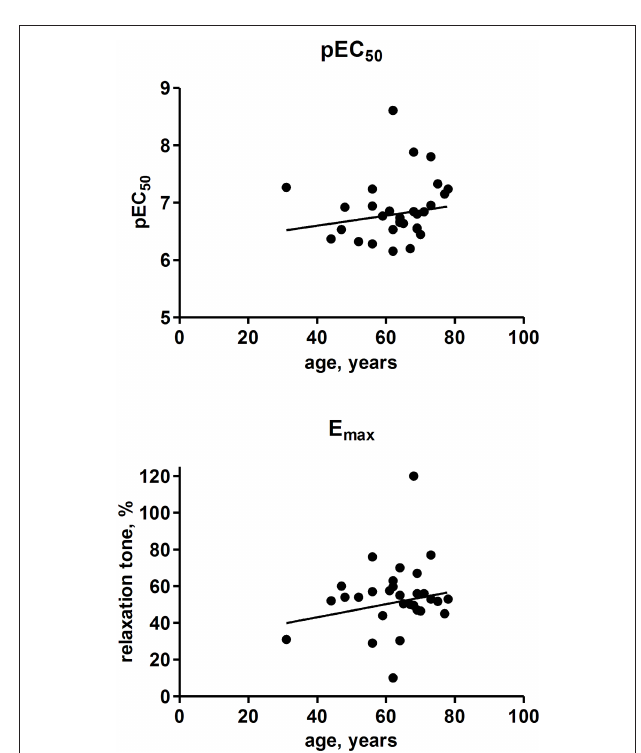
Figure 7 | effect of strength of contractile stimulus on the potency and efficacy of isoprenaline to relax human detrusor strips. Each data represents one strip (in total 54 strips from 30 patients), and data obtained on days 0–1 were included.